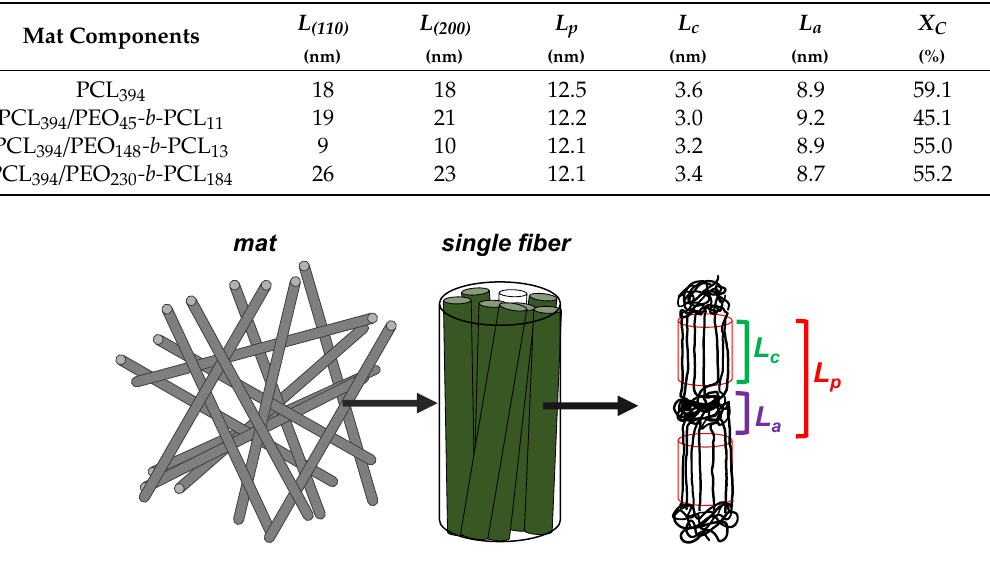
Figure 4. Schematic representation of crystalline and amorphous domains ordered in a PCL single fiber.